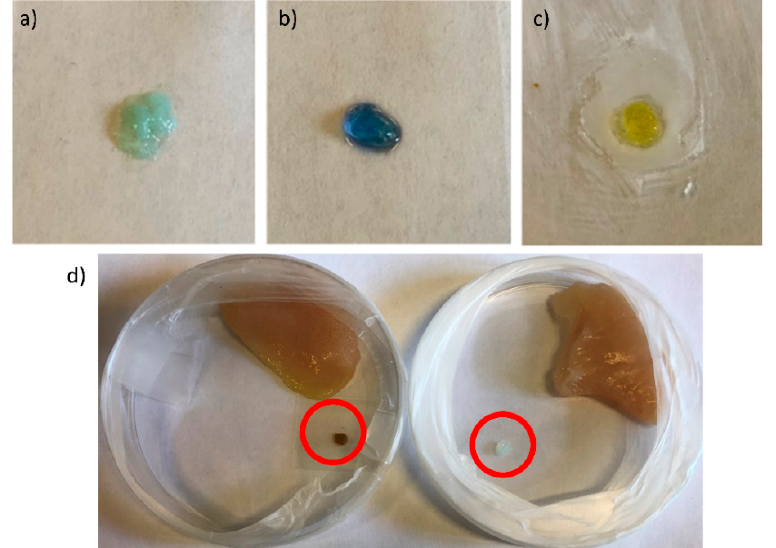
Figure 6. Images of the 1 -Cu 2+ gel ( a ) as prepared, ( b ) after exposure to ammonia vapors, and ( c ) after exposure to HCl vapors, ( d ) colorimetric responses of the 1 -Cu 2+ gel when exposed to chicken meat stored at 25 °C (left) and 4 °C (right).